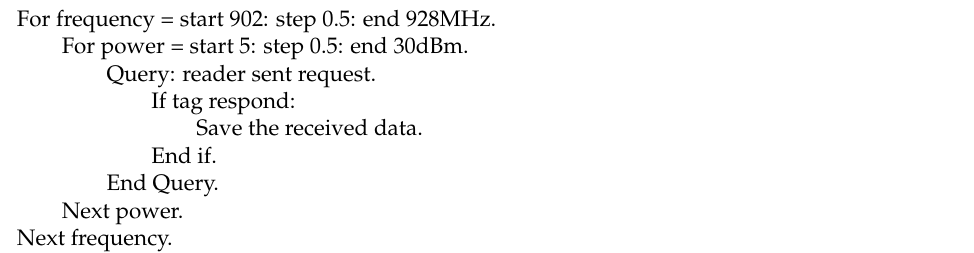
Table 8. Pseudocode of the interrogation